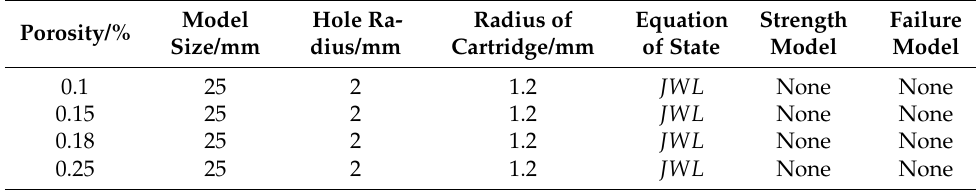
Table 2. Different porosity numerical simulation parameters.